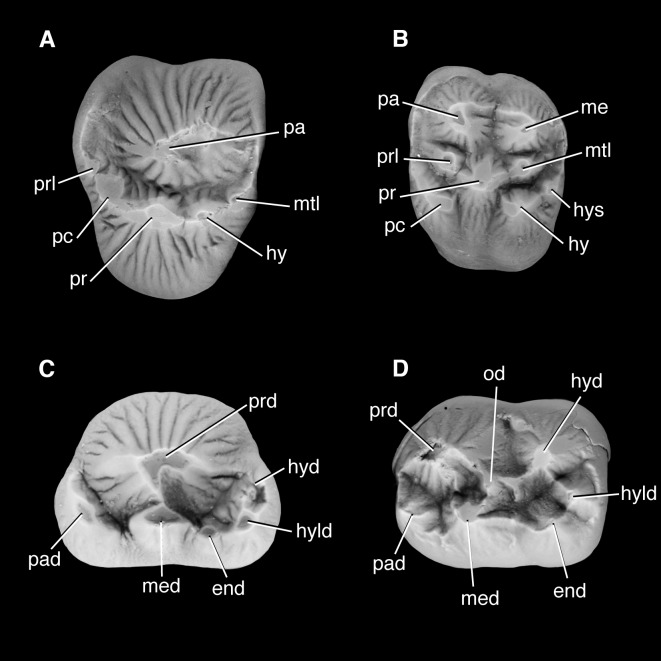
Tooth nomenclature for Periptychus carinidens.(A) upper premolar–P4 of NMMNH P-36631; (B) upper molar–M2 of NMMNH P-36631, (C) lower premolar—p4 of NMMNH P-36631; (D) lower molar—P4 of NMMNH P-19363. Abbreviations: end, entoconid; hy, hypocone; hyld, hypoconulid; hys, hypostyle; me, metacone; med, metaconid; mtl, metaconule; od, obliconid; pa, paracone; pad, paraconid; pc, pericone/protostyle; pr, protocone; prd, protoconid; prl, paraconule. Tooth images serve to identify cusps and are not to exact scale.